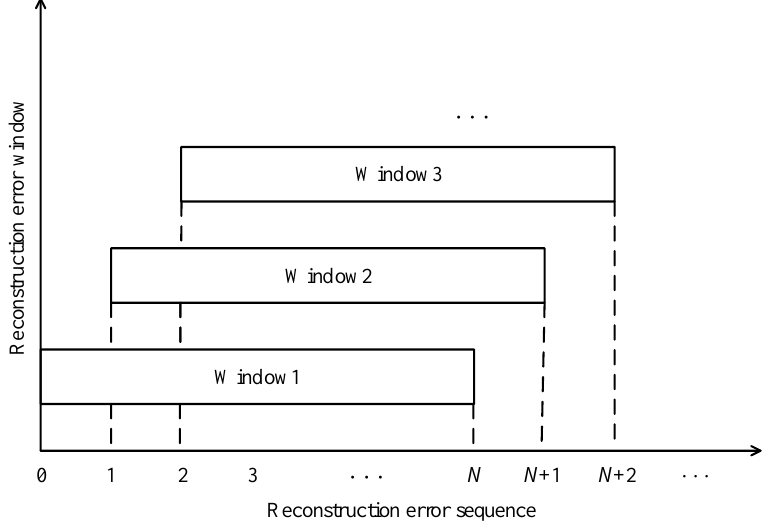
Figure 5. Reconstruction error sliding window.